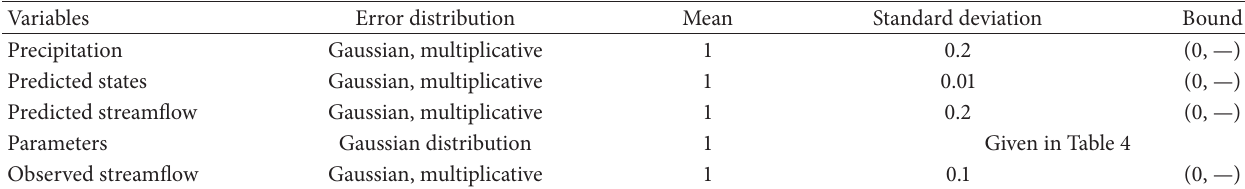
Table 3: Error parameters in the synthetic experiment.